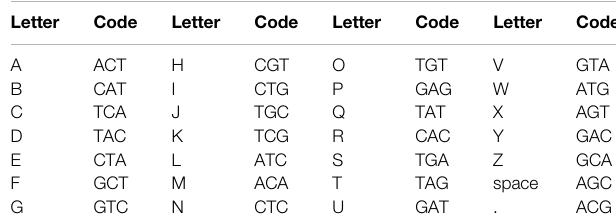
TABLE 1 | Translation table for DNA